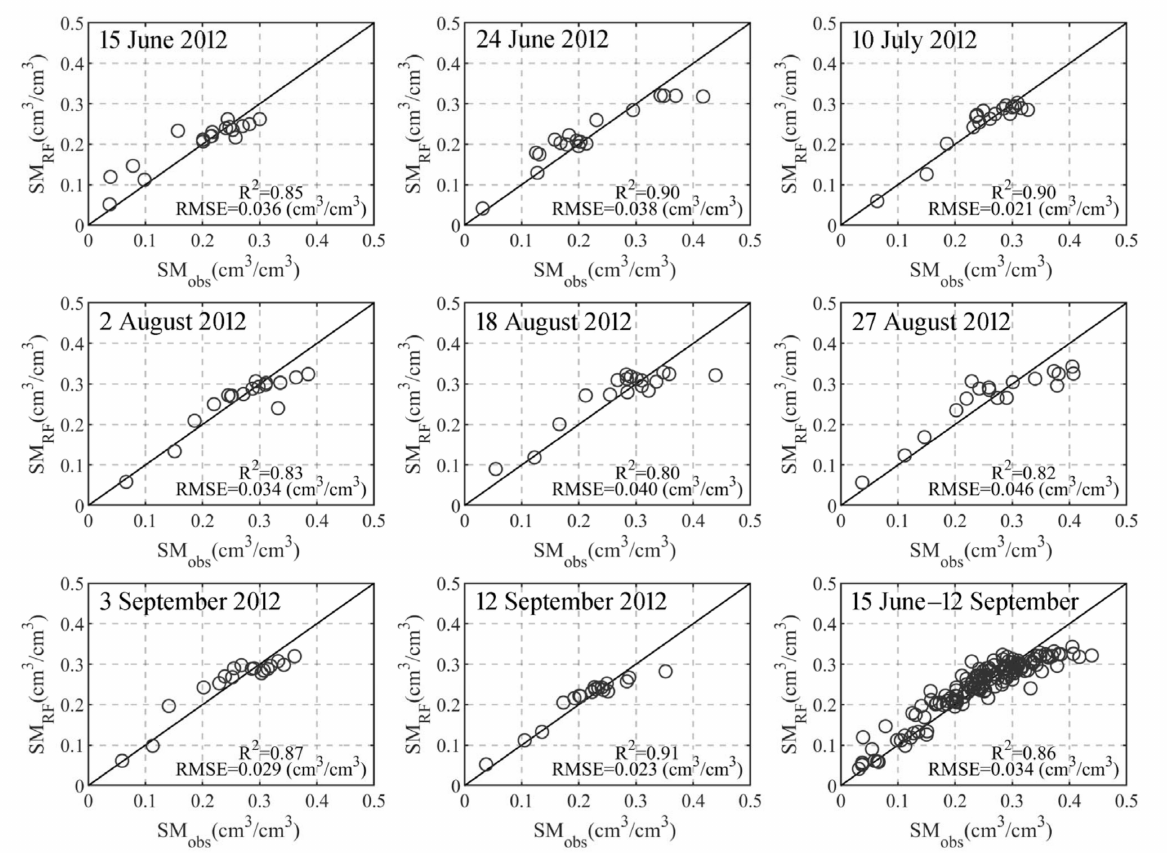
Figure 10. Scatter plots of the observed soil moisture and RF mapped soil moisture with the combina- tion H (LST, NDVI, and